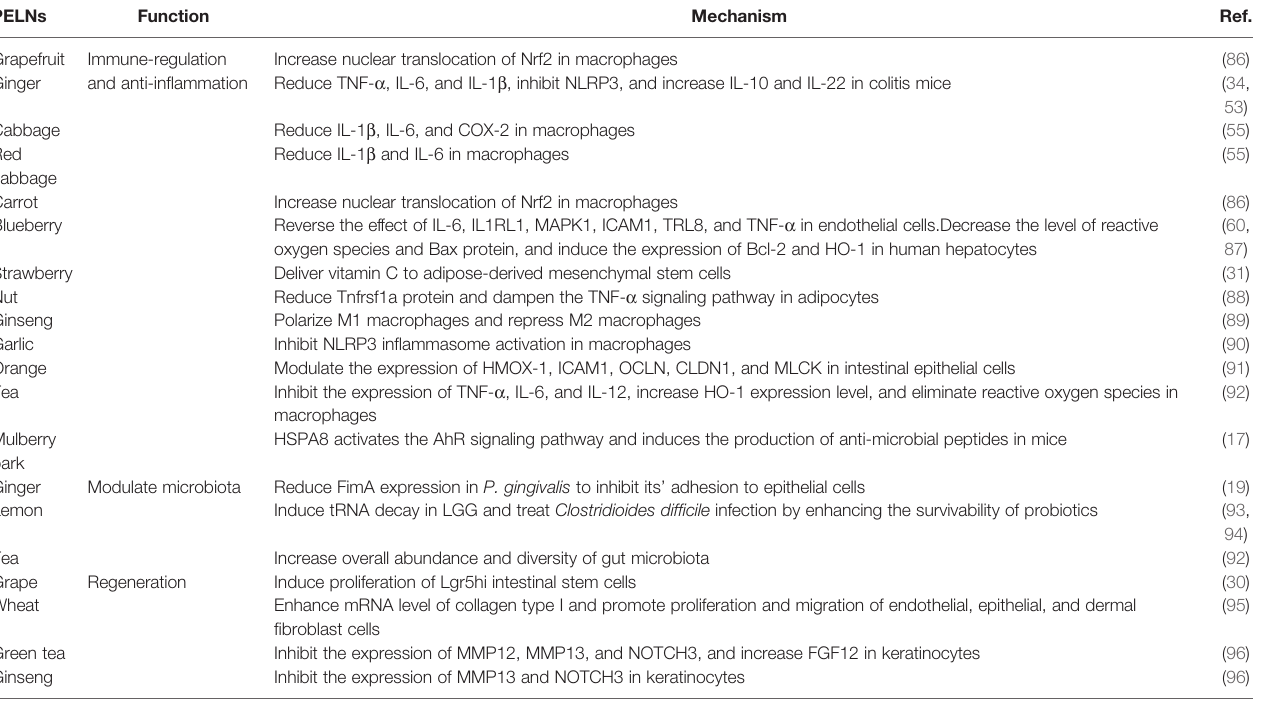
TABLE 1 | Overview of PELNs biological activities that could be applied in periodontitis